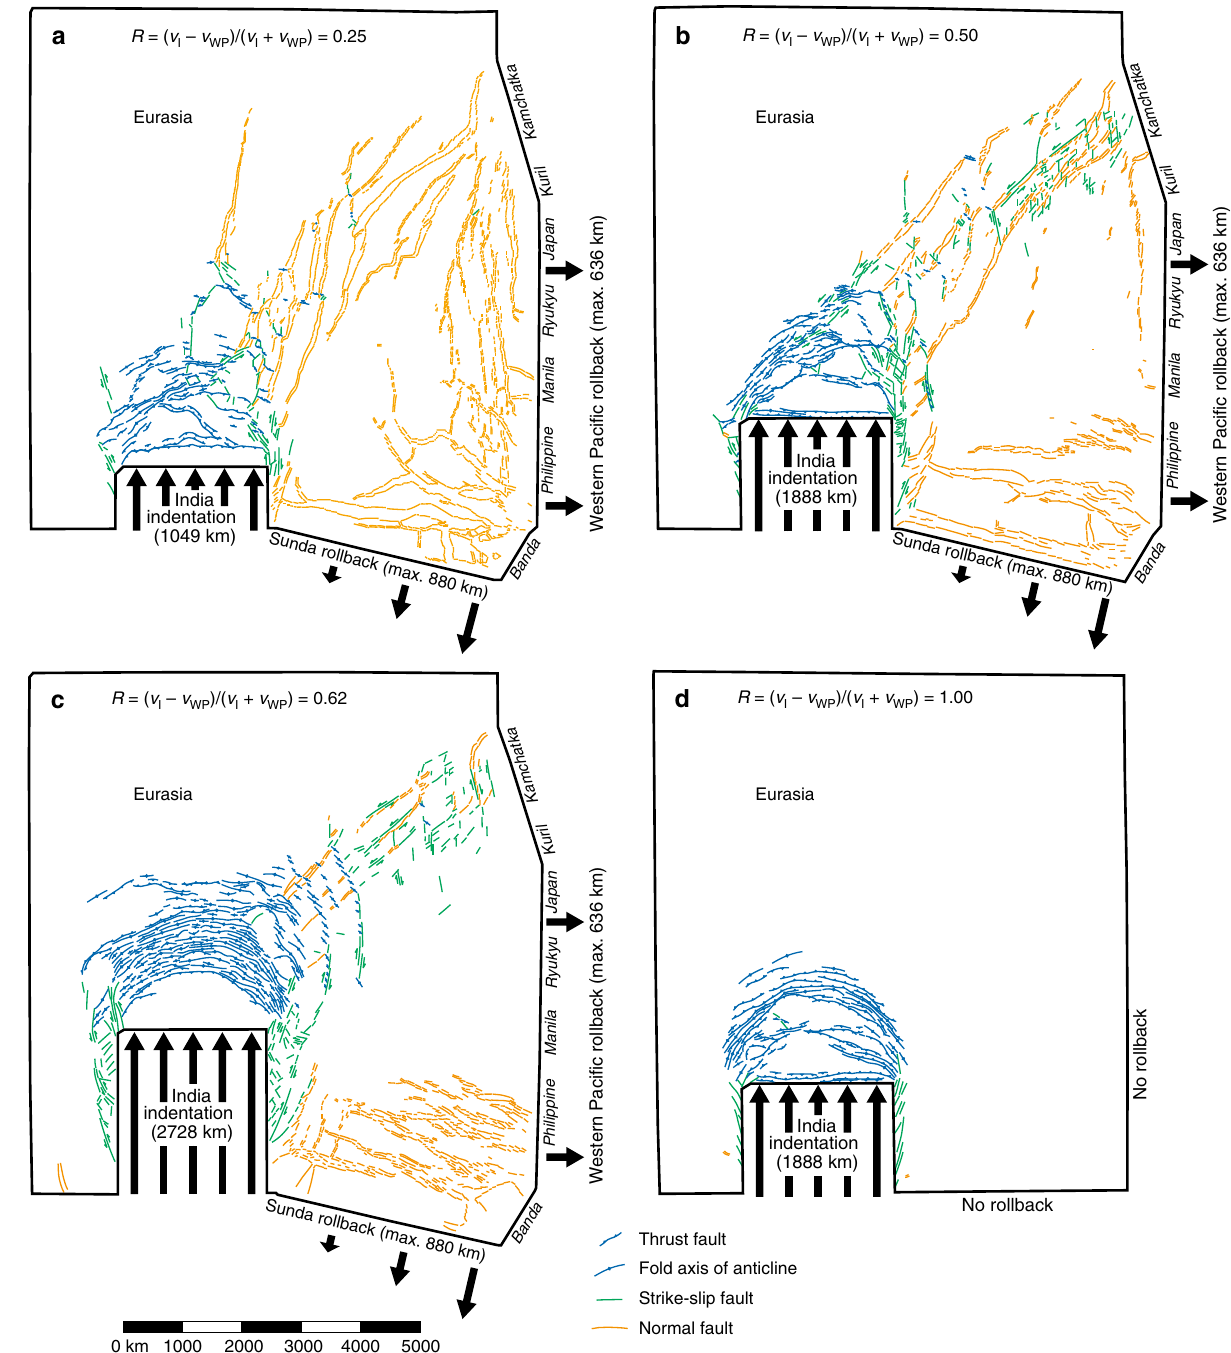
Fig. 4 Top views of four experiments simulating Asian deformation with different velocity ratios ( R ) showing the surface structures. The results are shown for the end of each experimental run. a Experiment I MIN -R with R = 0.25 (minimum indentation). b Experiment I INT -R with R = 0.50 (intermediate indentation). c Experiment I MAX -R with R = 0.62 (maximum indentation). d Experiment I INT -NR with R = 1.00 (intermediate indentation and no rollback). Note that thrust faults and anticlinal fold axes are in blue, strike-slip faults are in green and normal faults are in